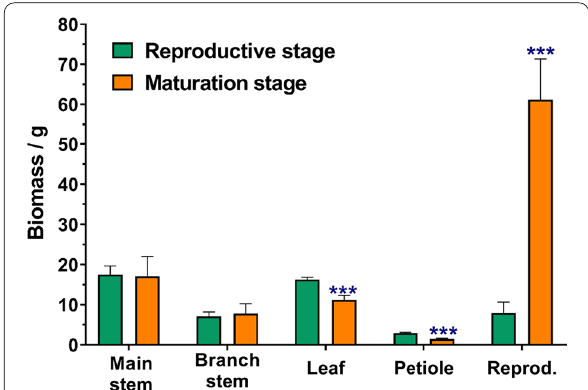
Fig. 3 Biomass allocation of field-grown cotton. Average biomass of main stem, branch stem, leaf blade, petiole, and reproductive tissues at reproductive stage (80 DAP) was compared with the corresponding organs at maturation stage (112 DAP). Data are present on the dry basis with average with standard deviation bars. Symbol *** above the bar indicates statistical significance ( P < 0.001) between the two stages (n 4). No significant difference at P 0.05 = = was found for the data pairs of main stem ( P 0.869) and branch = stem ( P =